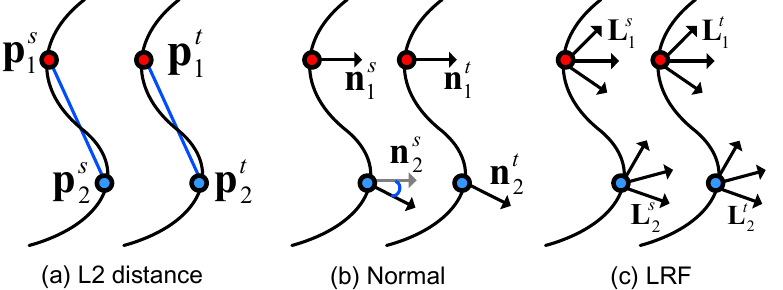
Figure 2. Three popular geometric constraints for the assessment of correspondence compatibility (illustrated in